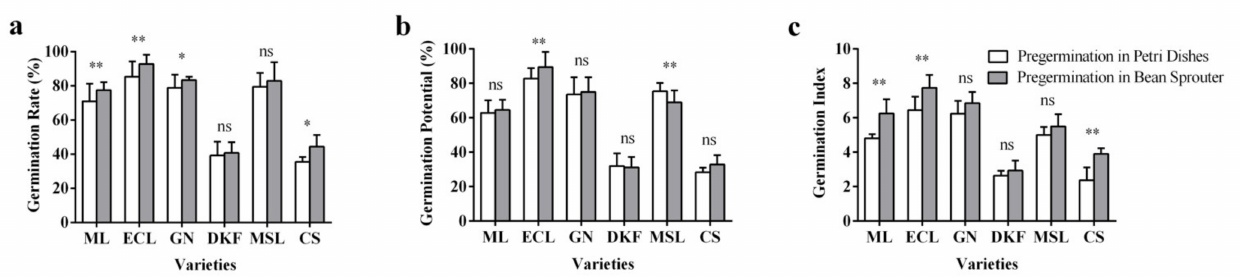
Figure 4. Effect of pre-germination treatments on seed germination characteristics of six tested varieties: ( a ) influence of pre-germination treatments on seed germination rate of tested varieties, ( b ) influence of seed germination treatments on seed germination potential of tested varieties, and ( c ) influence of pre-germination treatments on the germination index of tested varieties. Data in this figure were tested by Student’s t test; * p < 0.05 and ** p < 0.01 represent significant differences between treatments, and ns indicates not significant. ML, ECL, GN, DKF, MSL, and CS represent varieties of Meili, Ecolly, Garanior, Dunkelfelder, Marselan, and Cabernet